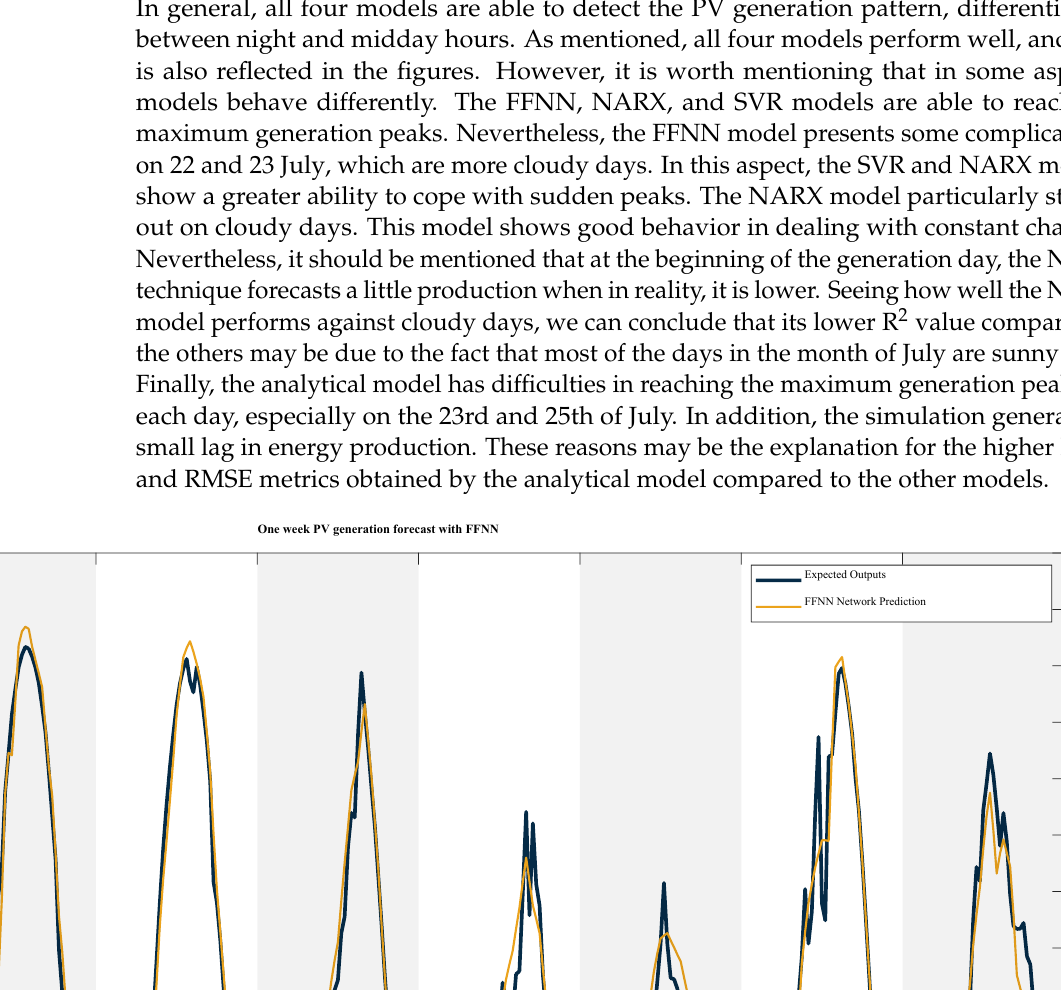
Figure 12. Forecast of PV generation for a week of July with NARX model.